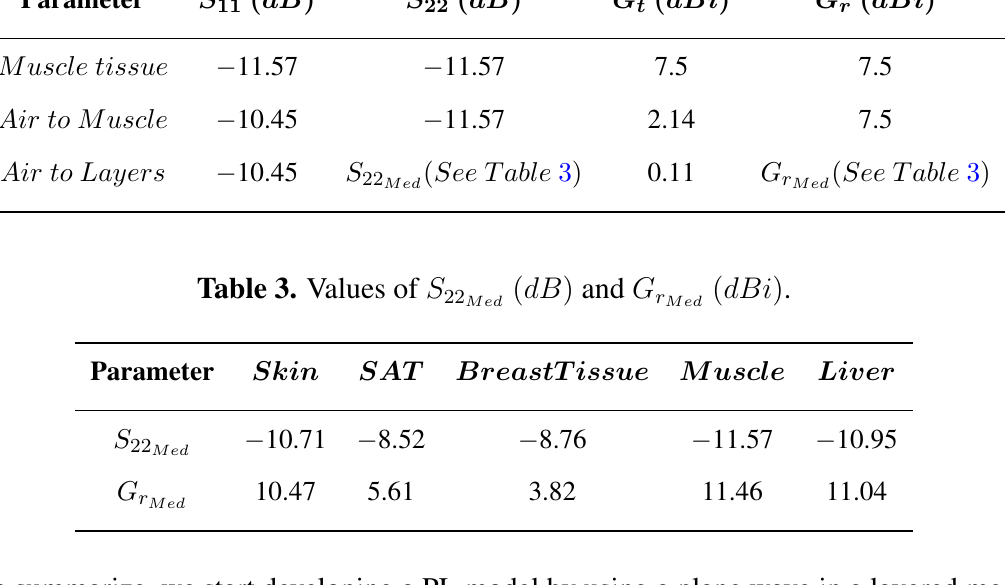
Table 2. Parameter values of the Friis transmission formula.